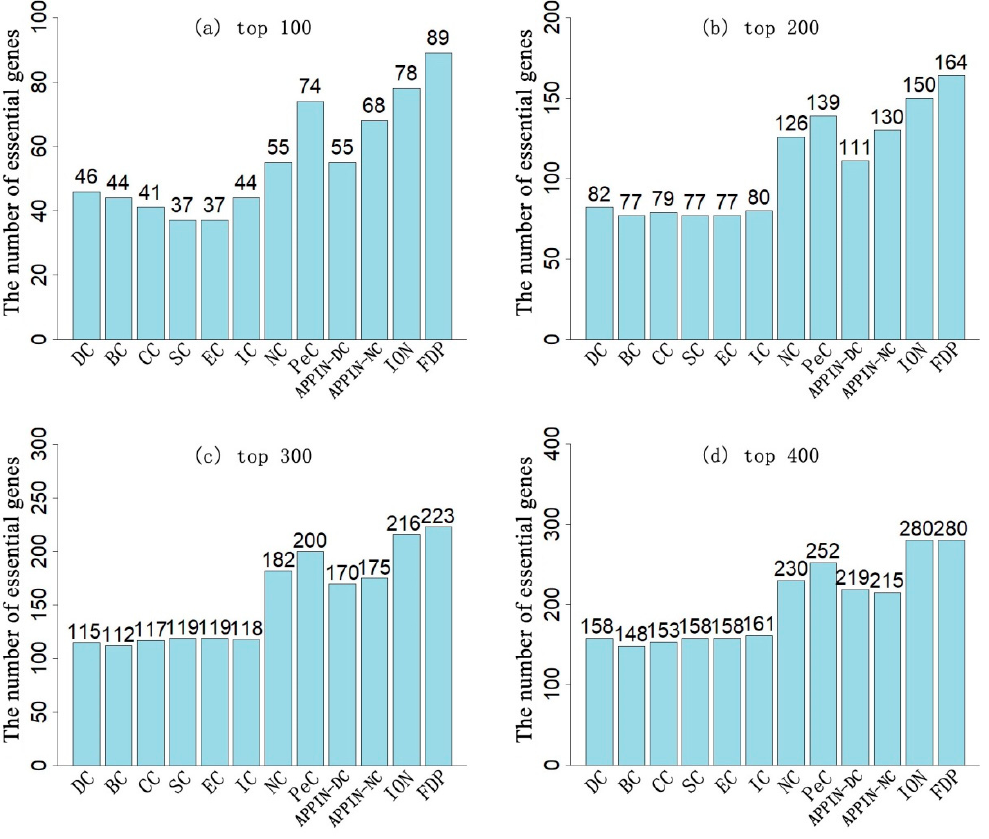
Figure 2. Comparison of the number of essential genes identified by the FDP and other existing methods based on the DIP_PPI network. ( a – d ) respectively show the results of these methods when selecting the top 100, 200, 300, and 400 of the ranked genes as candidate essential proteins. The data labels above the bars are the number of true essential proteins identified by the corresponding methods in each top number of ranked genes.